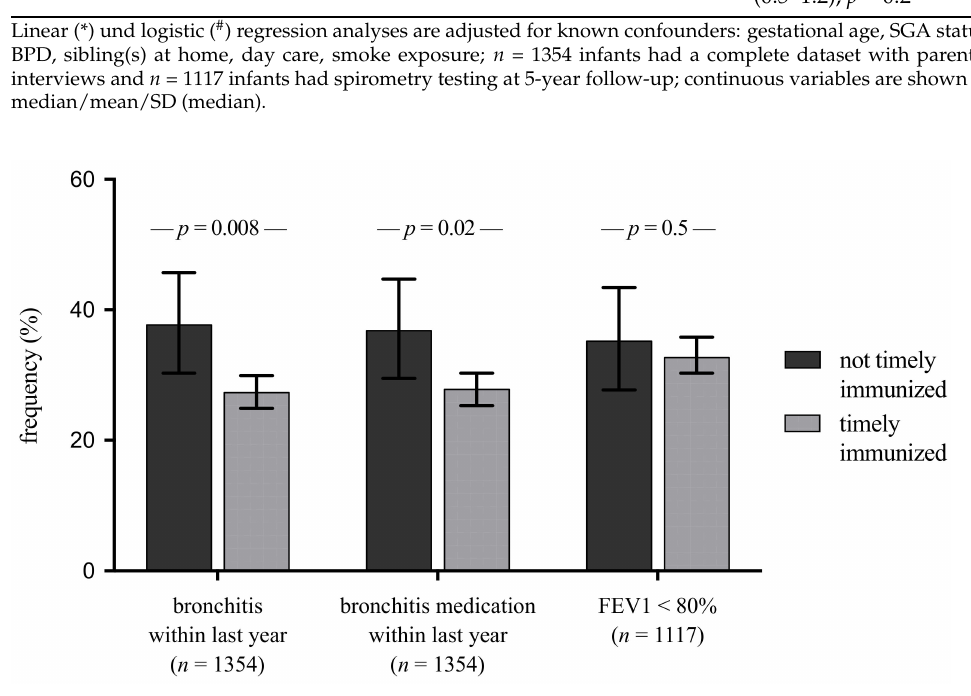
Figure 2. Outcome at 5 years of age: parent-reported bronchitis (medication) within last year and pathological FEV1. FEV1, forced expiratory volume in 1 s; p -values were derived from Pearson’s Chi-square